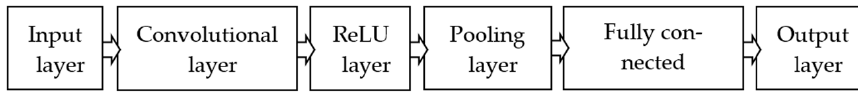
Figure 8. CNN model.